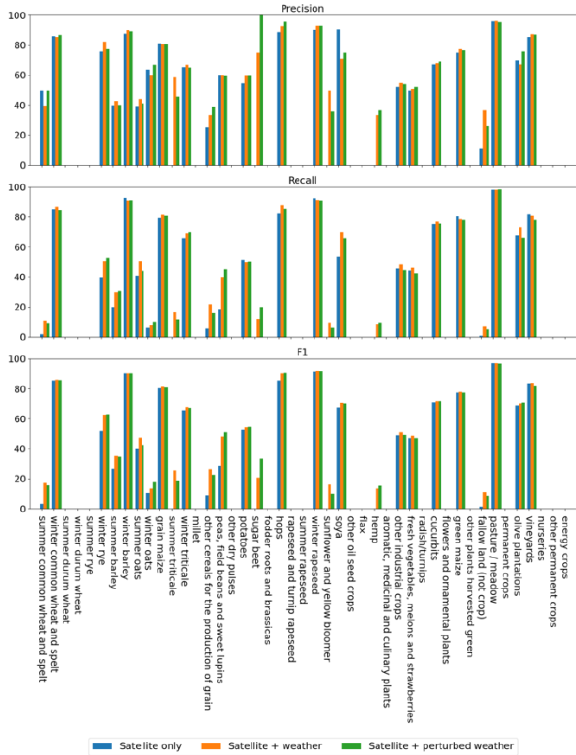
Figure 7. Class-specific scores (precision, recall, F1) obtained with a Transformer model trained only with satellite data (blue) and with both satellite and weather data (orange). In green, the scores obtained perturbing the weather data of the testing subset with Gaussian white